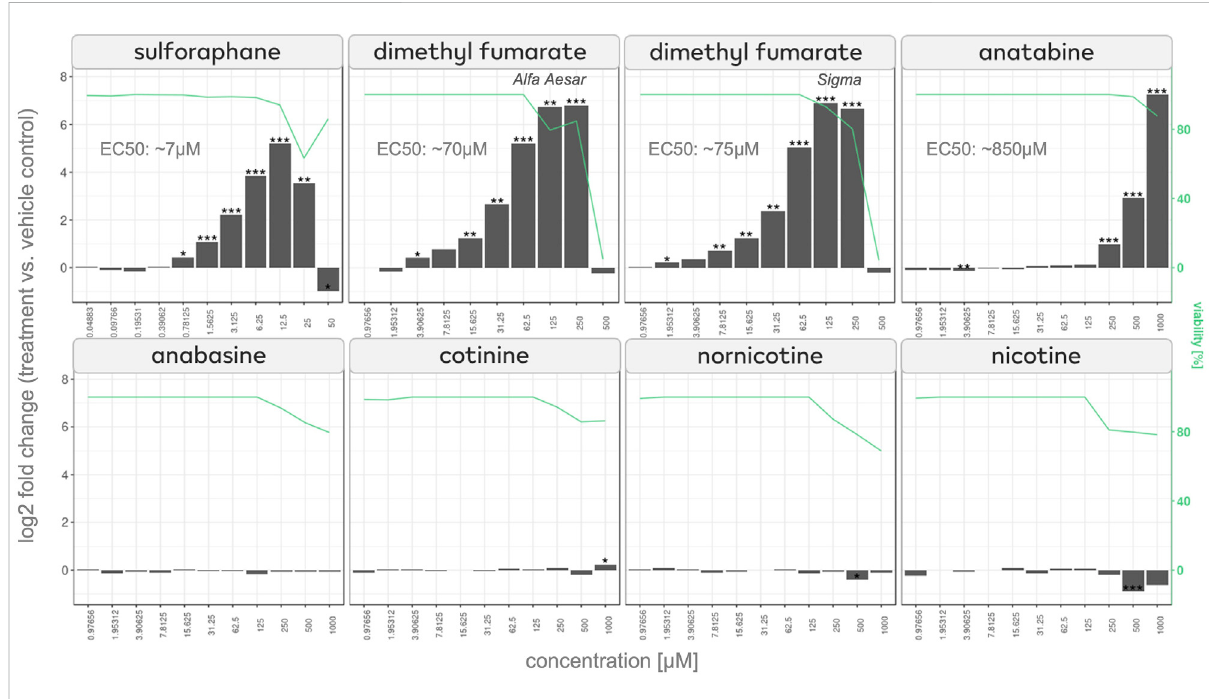
NRF2/ARE luciferase assay of effects of anatabine and other tobacco alkaloids NRF2 activation measured in NRF2 reporter cells after 24 h of stimulation of sulforaphane, dimethyl fumarate, anatabine, anabasine, cotinine, nornicotine, and nicotine. The corresponding cell viability is plotted on the right axis and depicted with a green